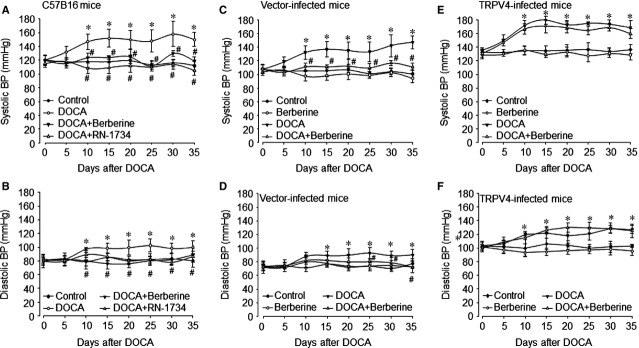
Administration of berberine via inhibition of TRPV4 reduces DOCA-induced hypertension in mice. (A and B) C57B16 mice at the age of 8–12 weeks old were fed with normal diet containing berberine (100 mg/kg/day) and RN-1734 (30 mg/kg/day) for 7 days prior to DOCA infusion. The hypertensive model was induced by DOCA (150 mg/kg) implantation. Blood pressures (BP) and heart rates were monitored by telemetry, as described in Materials and Methods. Systolic BP in A and diastolic BP in B were analysed. Quantitative results are expressed as mean ± SEM 10–15 mice in each group. *P < 0.05 versus Control mice. #P < 0.05 versus DOCA-implanted mice. (C and D) C57B16 mice at the age of 8-12 weeks were injected with adenovirus vector via tail vein. 2 weeks later, berberine (100 mg/kg/day) were provided in the diet followed by DOCA implantation for 35 days. Systolic BP in C and diastolic BP in D in adenovirus-vector-infected mice were analysed. Quantitative results are expressed as mean ± SEM 10–15 mice in each group. *P < 0.05 versus Mice infected with vector. #P < 0.05 versus DOCA-implanted mice infected with vector. (E and F) C57B16 mice were received infection of adenovirus containing TRPV4 cDNA by tail vein injection followed by administration of berberine (100 mg/kg/day) and DOCA (150 mg/kg) implantation. Systolic BP in E and diastolic BP in F in mice infected adenovirus containing TRPV4 cDNA were analysed. Quantitative results are expressed as mean ± SEM 10–15 mice in each group. *P < 0.05 versus Mice infected with TRPV4 cDNA.